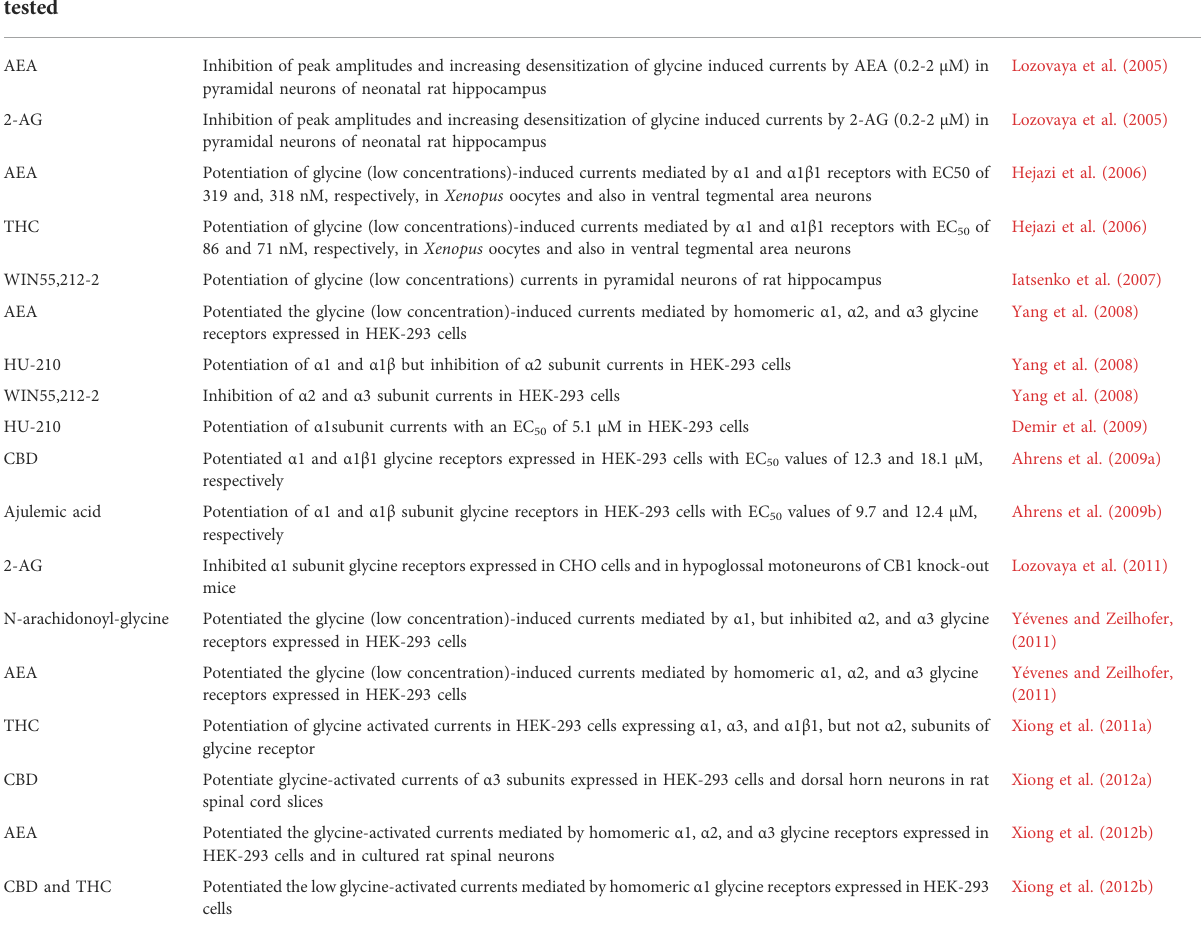
TABLE 3 Effects of cannabinoids on glycine